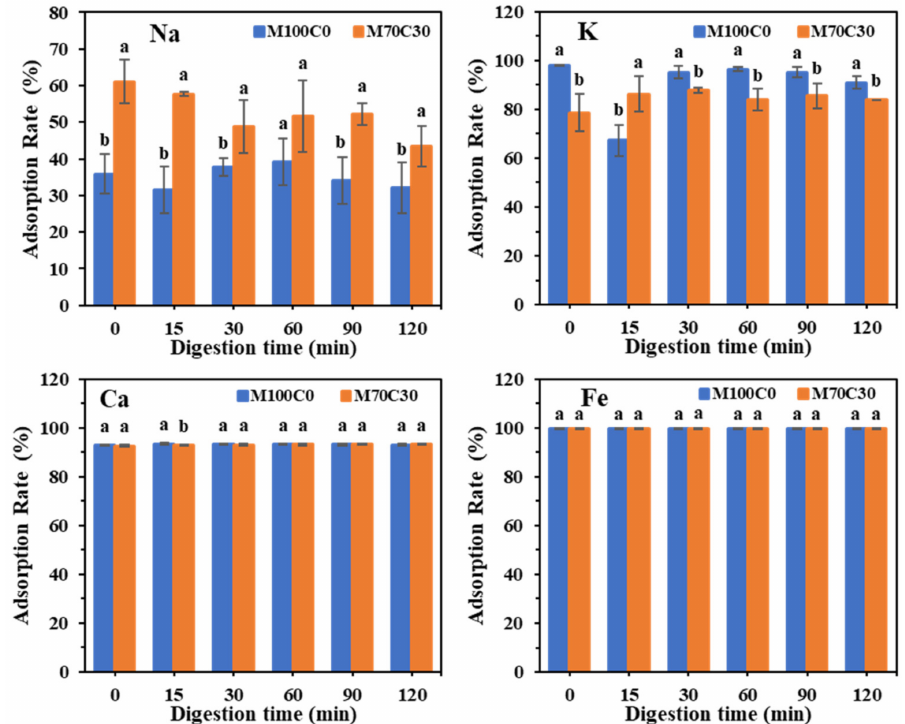
Figure 8. Adsorption rates of different ions on protein after digestion. Different lowercase letters indicate a significant difference in ion adsorption rates between the two emulsions after the same digestion time. p <